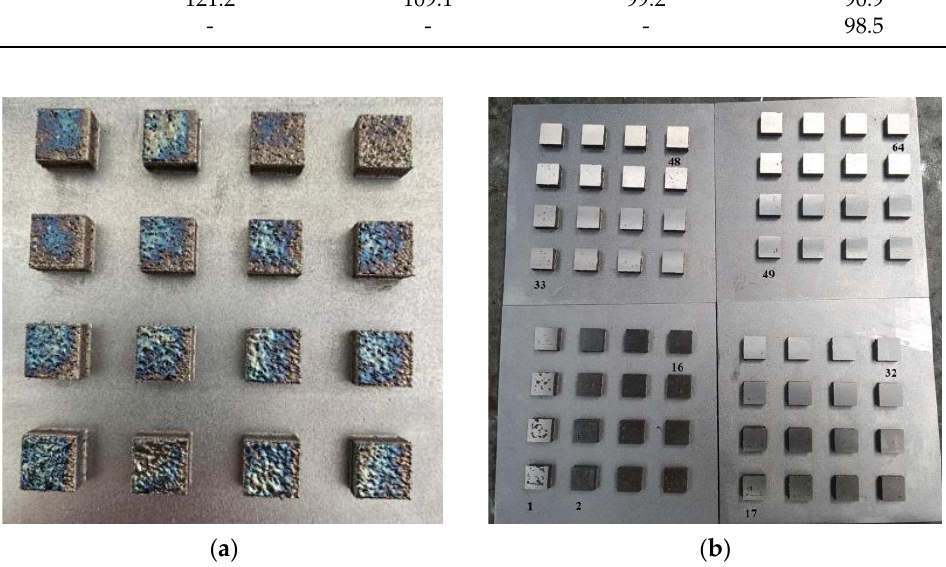
Figure 5. ( a ) Building job after 3D printing; ( b ) Building platforms after